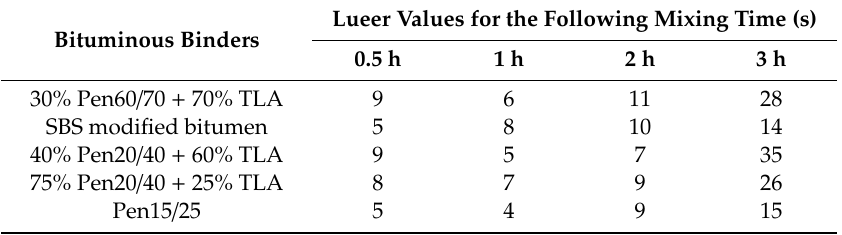
Table 4. E ff ect of bituminous binder type and mixing time on Lueer value. Lueer Values for the Following Mixing Time Bituminous Binders